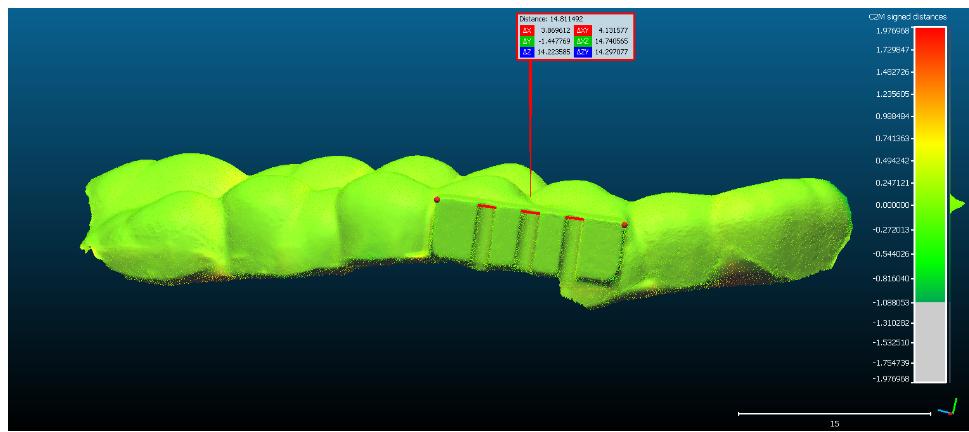
Figure 5. The scaling of the optical scan of the mouth guard, after it had been aligned with the ref- erence object. reference